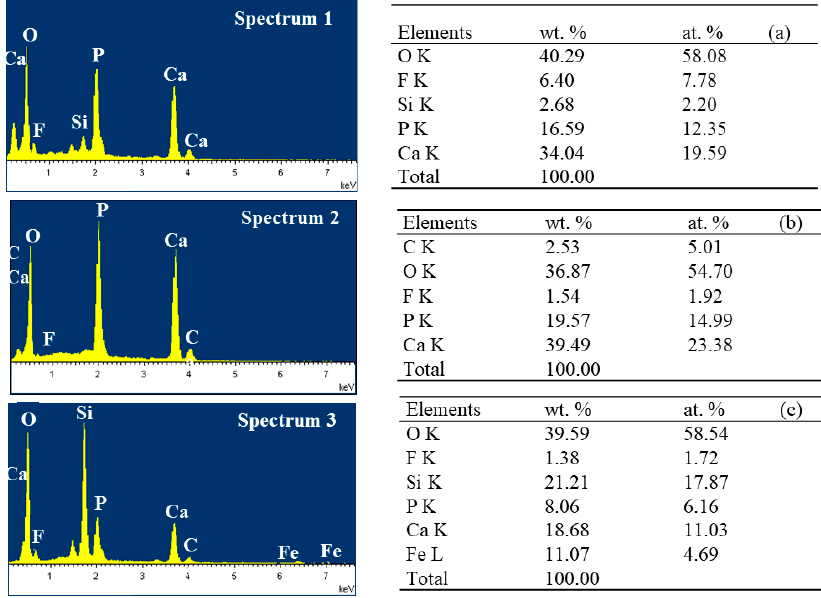
Figure 7. Energy dispersive X-ray spectroscopy (EDS) images of three PR powders and their elemental compositions.